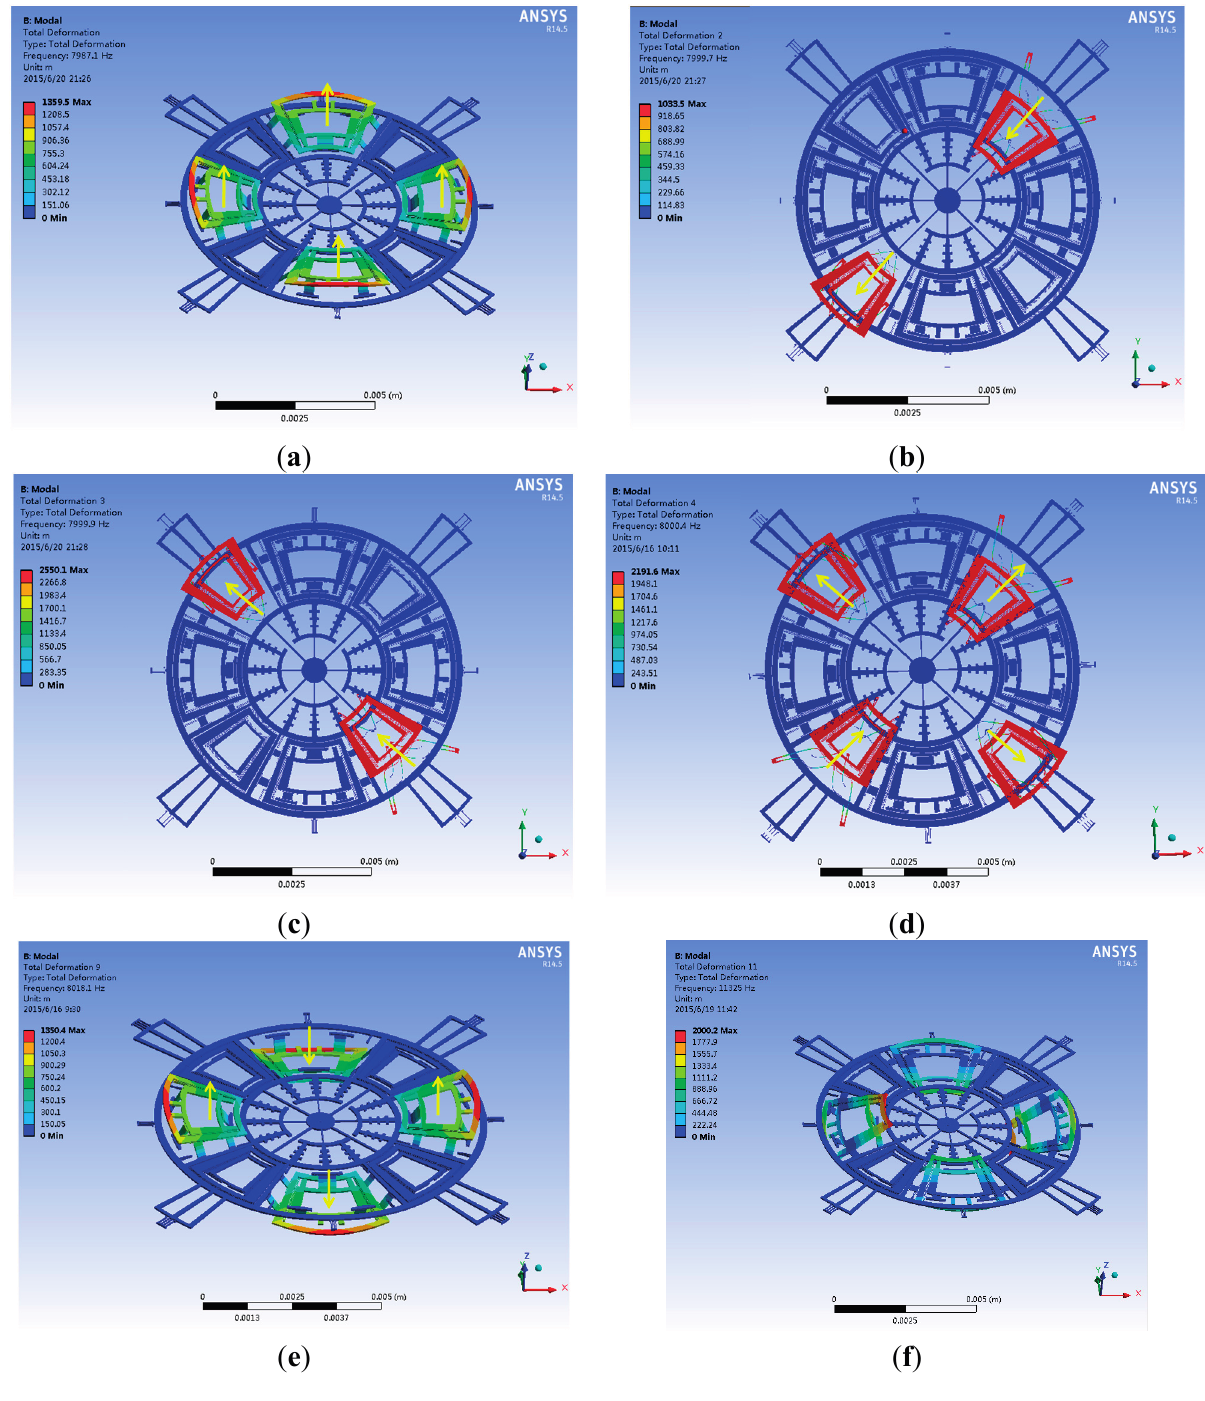
Figure 4. The interference modes of the tri-axis gyroscope: ( a , e , f ) The interference modes of pitch/roll frames; ( b – d ) The interference modes of yaw